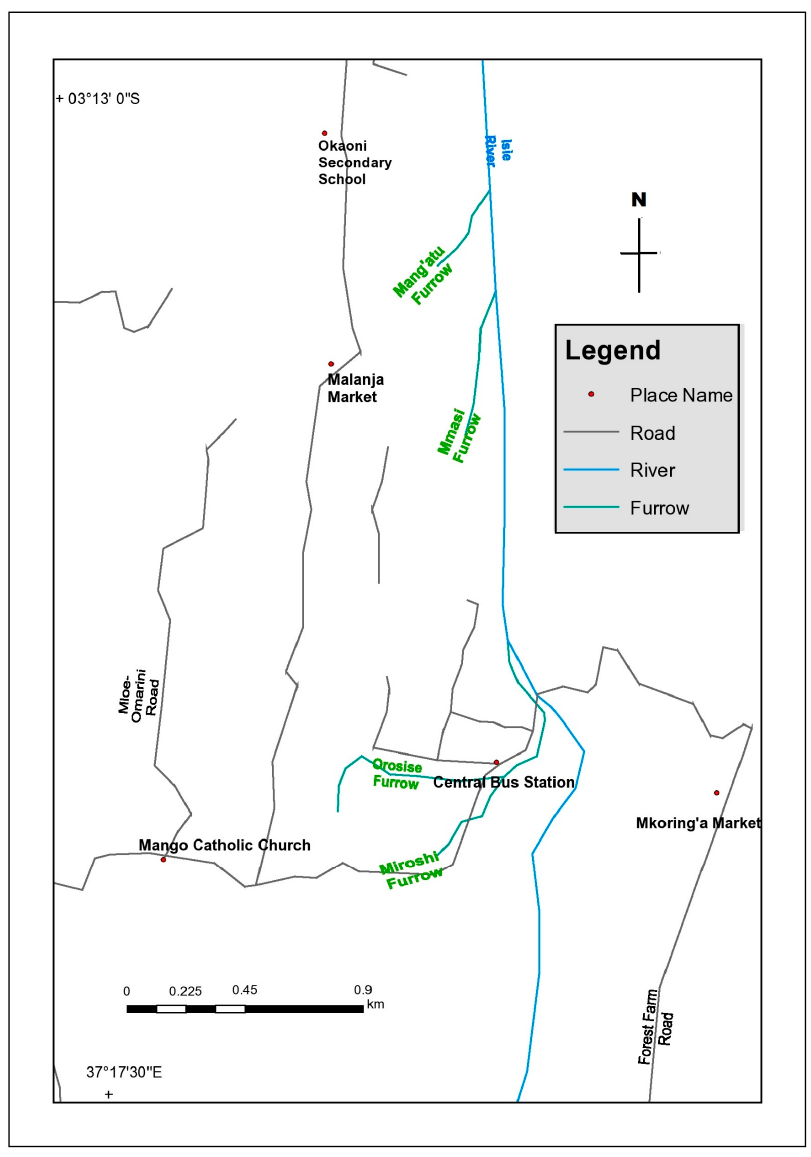
Figure 2. Irrigation furrows along Isie River, Kibosho (image courtesy of the GIS Laboratory, Stella Maris Mutwara University